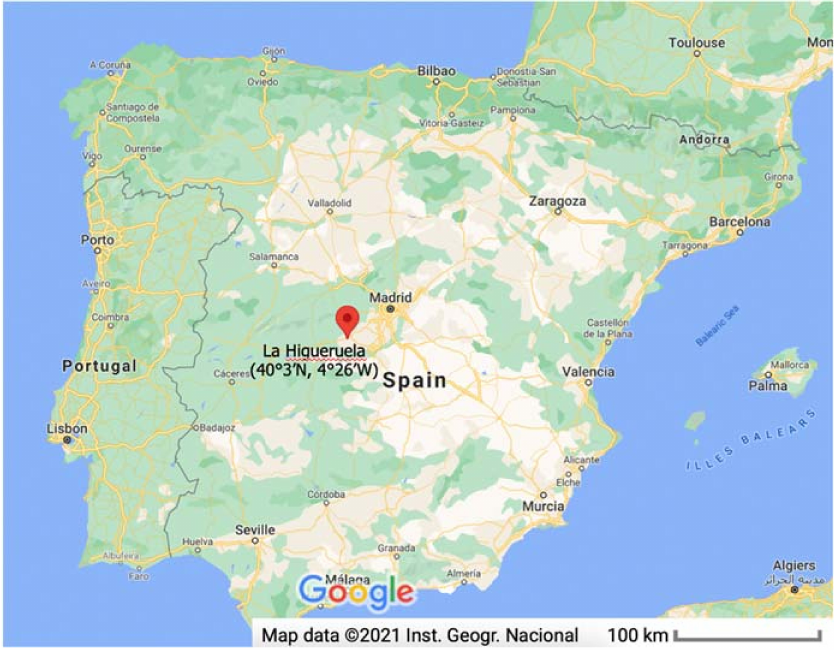
Figure 1. Location of the CIEMAT OTC facility at the “La Higueruela” MNCN/CSIC Research Farm (Santa Olalla municipality, Toledo,